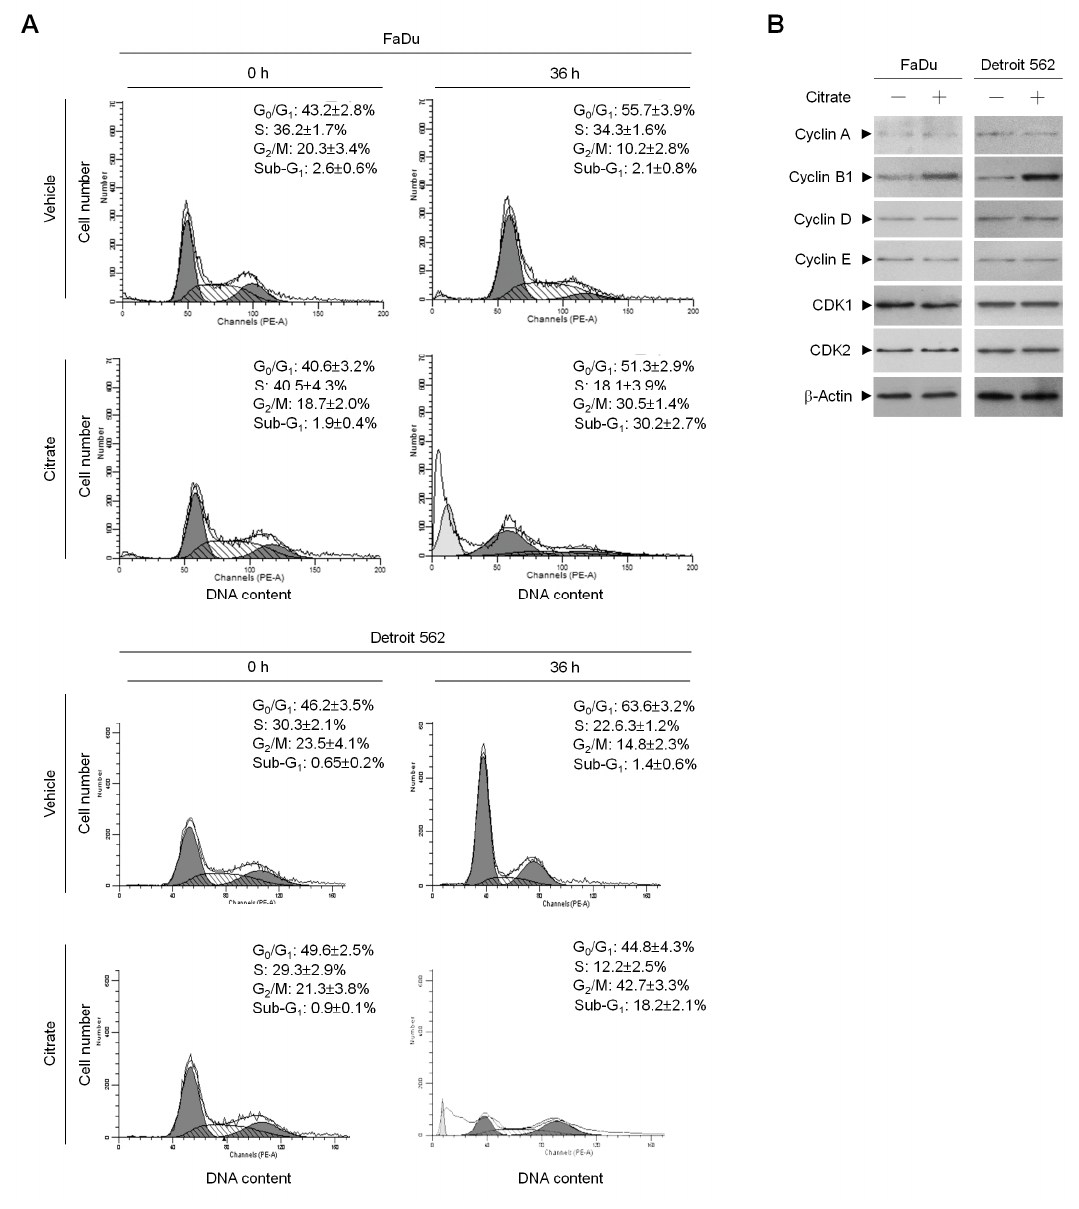
Figure 2. Citrate induces G 2 / M phase arrest of human PSC cells. ( A , B ) After treatment of the cells with vehicle ( − ) or citrate (10 mM) for 36 h, the levels of the indicated proteins in the cell lysates and cell cycle phase were determined using Western blot analysis with specific antibodies and flow cytometric analysis of PI-stained cells, respectively. The values are presented as the means ± standard error of three independent experiments. β -Actin was used as an internal control for sample loading.